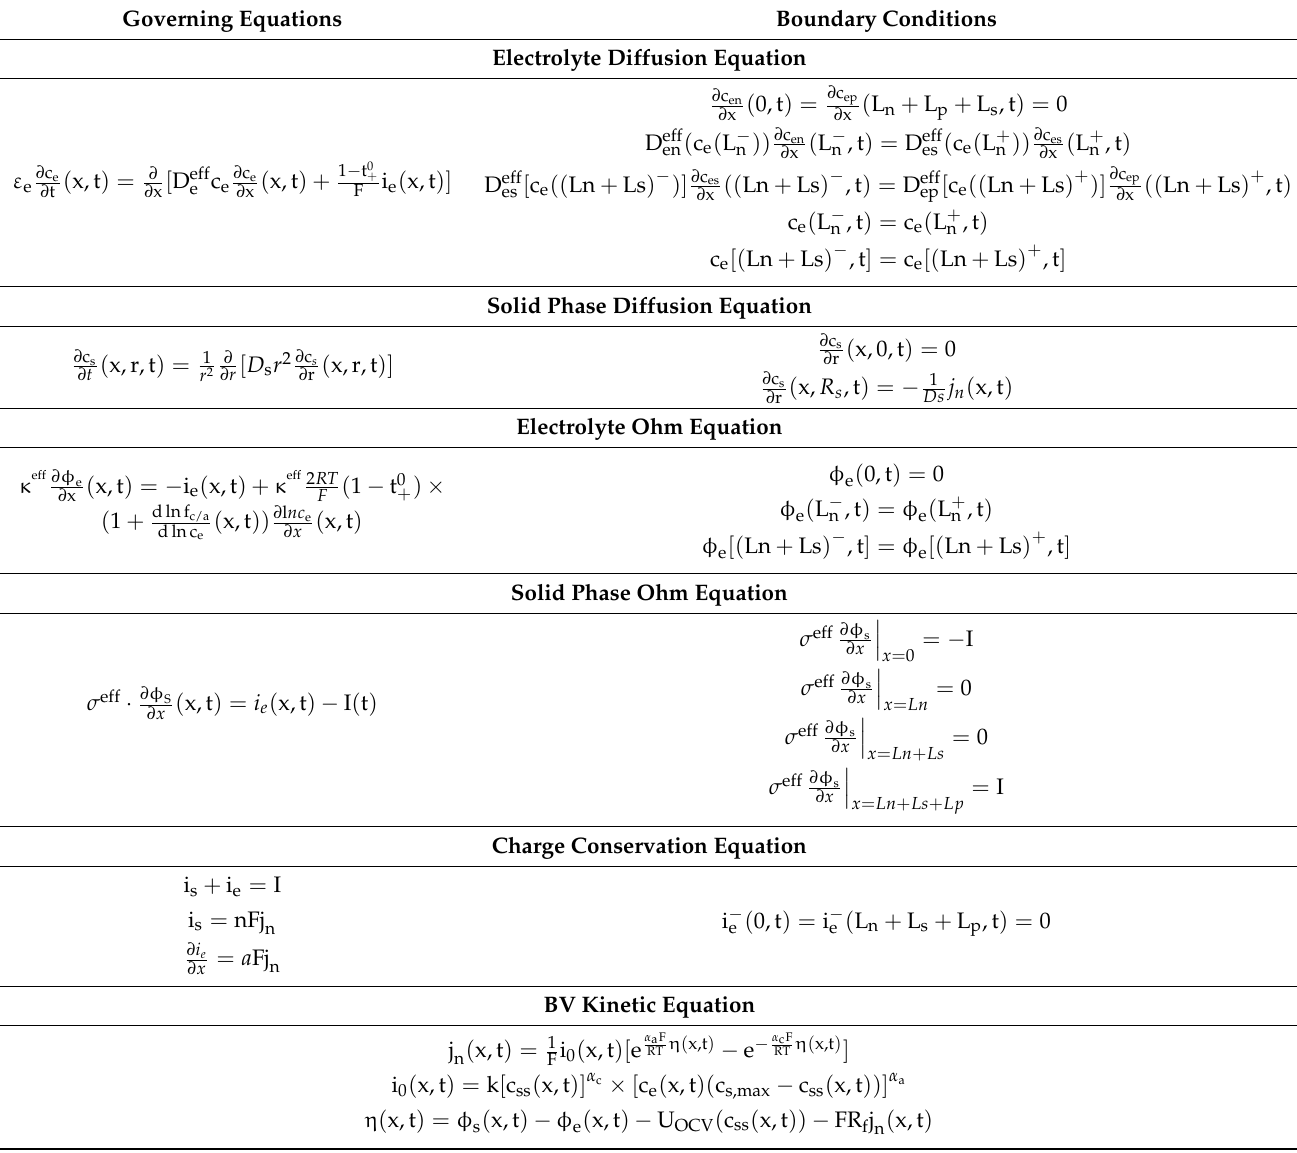
Table 1. Mathematical equations and boundary conditions of the P2D